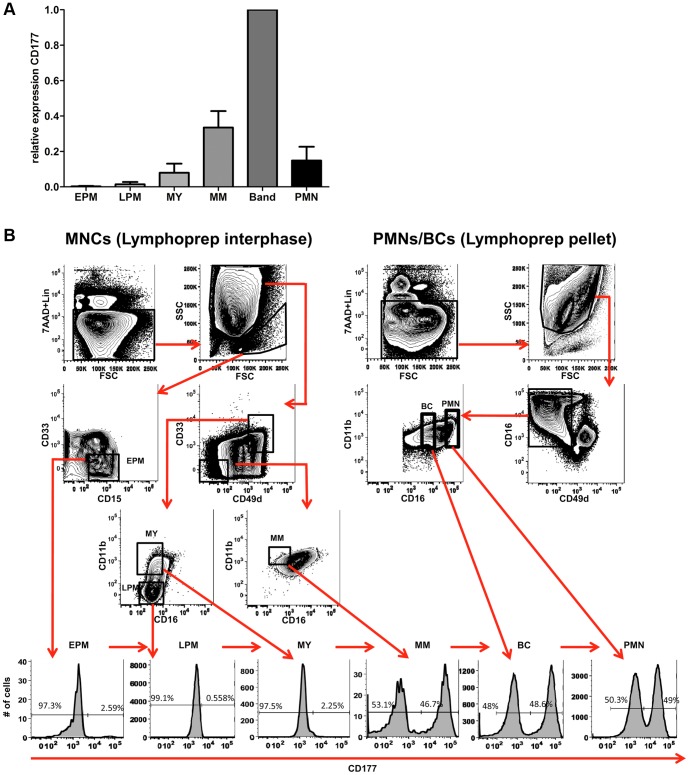
CD177 expression during terminal neutrophil differentiation.BM populations representing successive stages of neutrophil differentiation were isolated from healthy donors by lymphoprep centrifugation followed by immunomagnetic depletion of non-granolocytic cells (MACS) and flow cytometry-based cell sorting. In short, BM was obtained from healthy controls, depleted of erythrocytes and subjected to one-layer density gradient centrifugation using Lymphoprep. The resultant interphase exists of mononuclear cells (MNCs), containing hematopietic stem/progenitor cells and mature cells of all hematopoietic lineages, and the cell pellet contains primarily PMNs and band cells (BCs). Non-granulocytic cells were depleted using a cocktail of biotinylated mAbs followed by incubation with anti-biotin antibody, conjugated with magnetic beads, and run on MACS separation columns (Miltenyi, Bergisch Gladbach, Germany). The resultant lineage-depleted cells are stained with a cocktail of fluorochrome-conjugated MoAbs and streptavidin-PE-Cy5. Addition of streptavidin-PE-Cy5 stains residual non-granulocytic cells that are labeled by biotinylated lineage-specific MoAbs, which allows for additional depletion of non-granulocytic cells during cell sorting. After staining cells were washed and resuspended in PBS/3%FCS containing the DNA dye 7AAD, which allows for sorting of viable non-apoptotic cells (i.e. 7AAD negative cells). Subsequently, the six BM populations representing the successive stages of terminal neutrophil differentiation were sorted using the FACSAria Cell sorter (BD Biosciences, San Jose, CA, USA). (A) mRNA expression of CD177 by quantitative RT-PCR in BM populations from 4 donors was determined and normalized against β-actin. (B) Representative example of CD177 expression on each BM population was measured by flow cytometry. Abbreviations: EPM, early promyelocyte; LPM, late promyelocyte: MY, myelocyte; MM, metamyelocytes; BC, band cells; MNC, mononuclear cells; PMN, polymorphonuclear cells; BM, bone marrow; PB, peripheral blood.